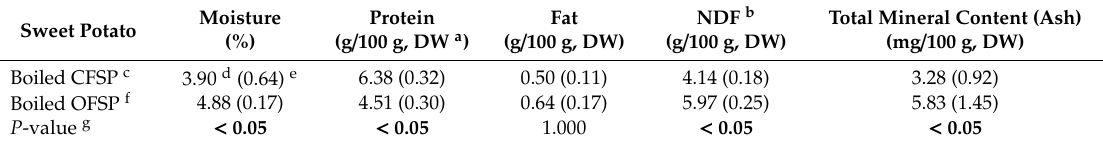
Table 2. Nutritional composition of cooked sweet